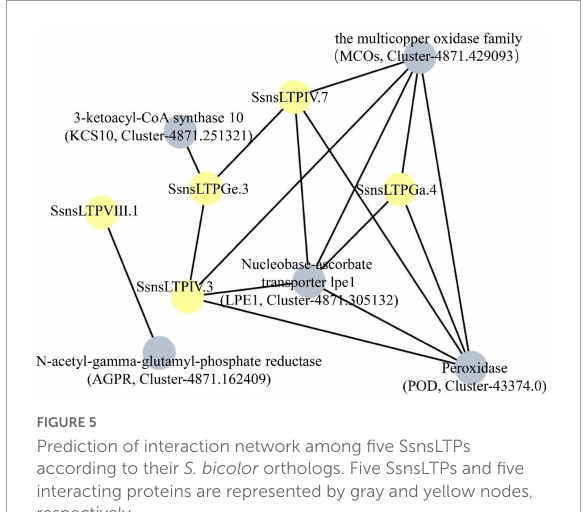
FIGURE5 Prediction of interaction network among five SsnsLTPs according to their S. bicolor orthologs. Five SsnsLTPs and five interacting proteins are represented by gray and yellow nodes,